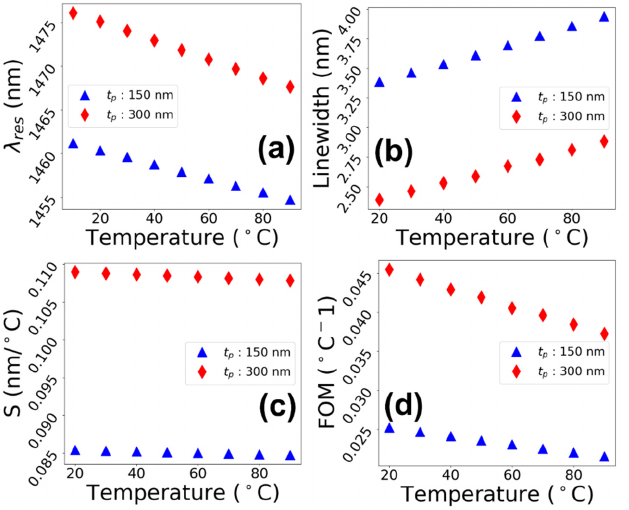
Figure 6. Sensing characteristics of the device: ( a ) λ res vs. temperature; ( b ) Linewidth vs. Temperature; ( c ) S vs. Temperature; and ( d ) FOM vs. Temperature.